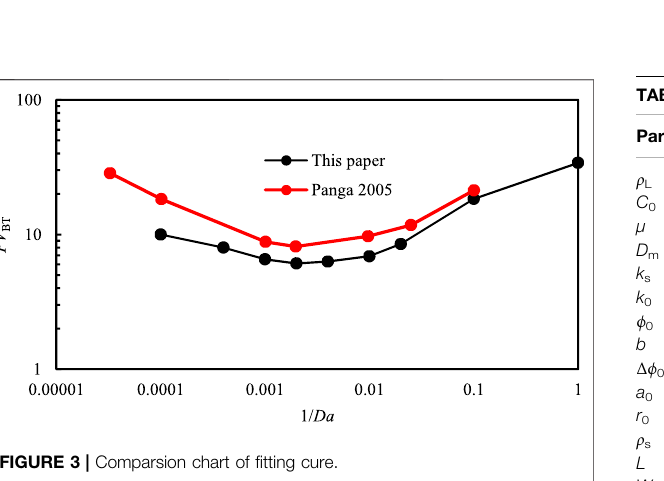
FIGURE 2 | Comparison of physical experiment and numerical simulation.